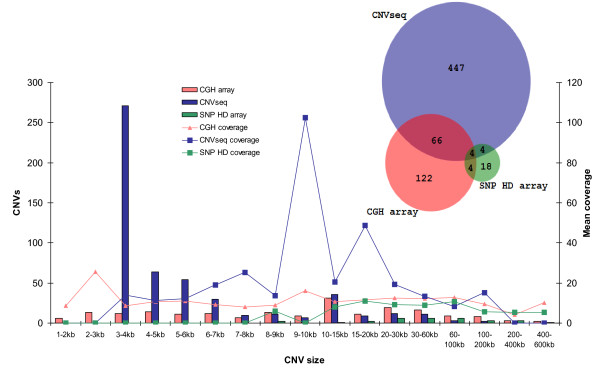
Comparison between different platforms. The Venn diagram depicts the number of CNVs that overlap among the three platforms; CGH array (red), CNV-seq (blue), and SNP HD array (green). The bar plot depicts CNV size distribution for each platform in each of the size ranges; the line plot represents the mean coverage of CNVs found in each size range.